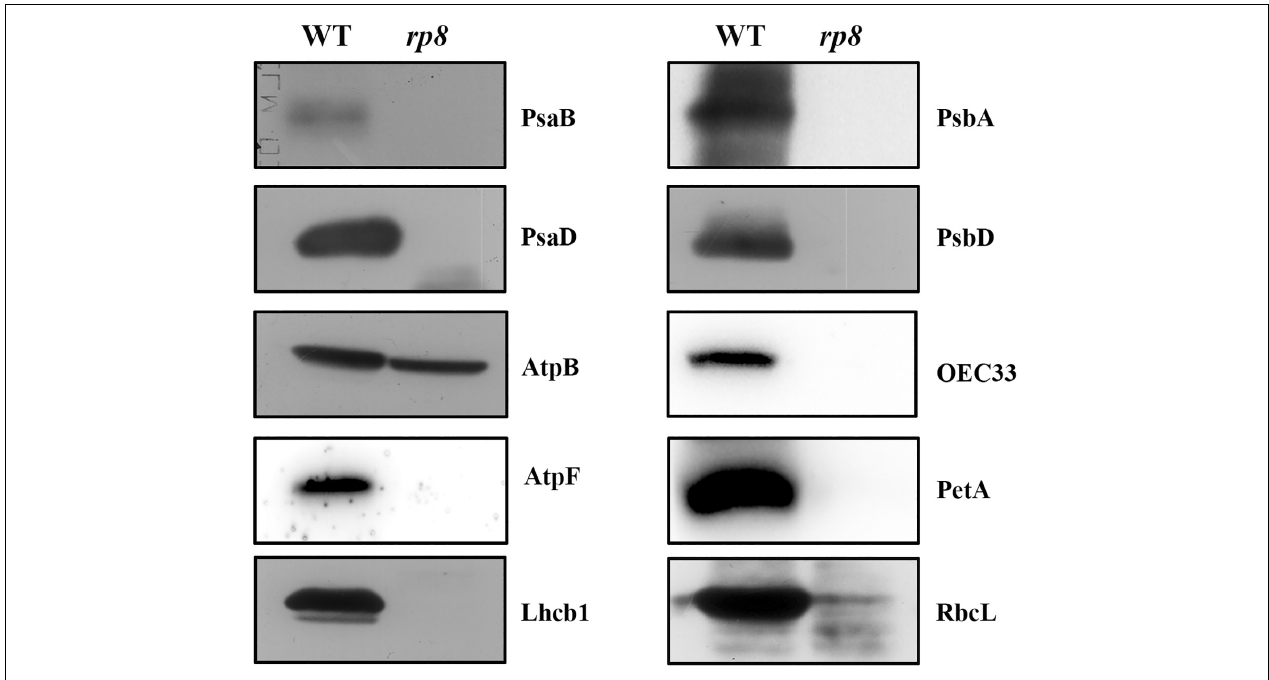
FIGURE 5 | Accumulation of photosynthetic proteins in the wild type and the rp8 mutant. Immunoblot analysis of photosynthetic proteins PsaB, PsaD, AtpB, AtpF, Lhcb1, PsbA, PsbD, OEC33, PetA, and RbcL from the wild type (WT) and the rp8 mutant using the corresponding antibodies, respectively. Each lane was loaded with 30 µ g total